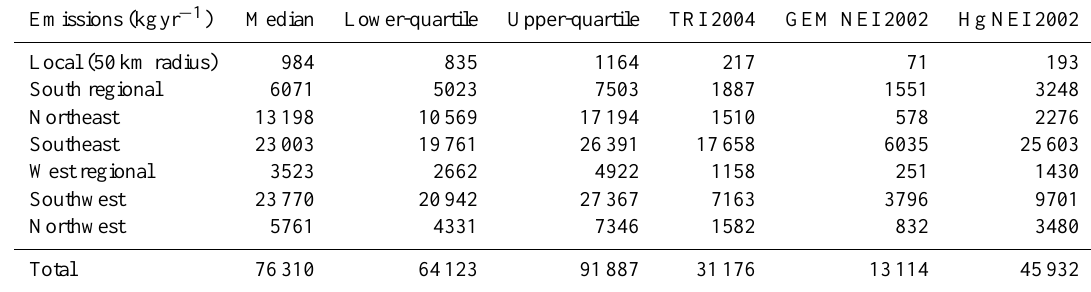
Table 3. Comparison of emission estimates from the inverse model (shown in Fig. 8) with those from the US Environmental Protection Agency’s Toxic Release Inventory (TRI) and National Emission Inventory (NEI) (shown in Fig. 13). Median, lower-quartile and upper- quartile values are obtained from 100 bootstrapped runs of the inverse model. Emission amounts are tabulated according to the geographical domains shown in Fig. 11.